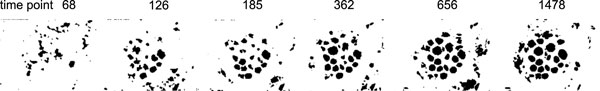
Real-time experiment-Incremental map construction
. Development of a glomerulus map during a real-time experiment. The images show incremental updates of the map at different time points. Parameters: k = 50 (number of PCs), c = 50. As preprocessing, images were spatially filtered (Gaussian kernel, width = 9).